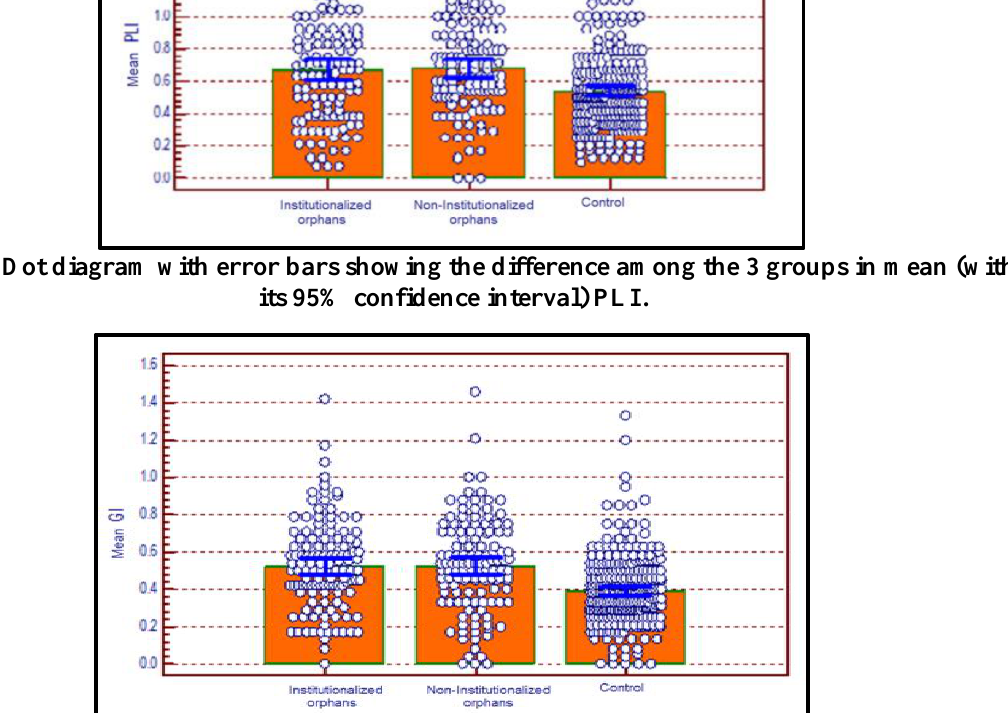
Figure 3: Dot diagram with error bars showing the difference among the 3 groups in mean (with its 95% confidence interval)